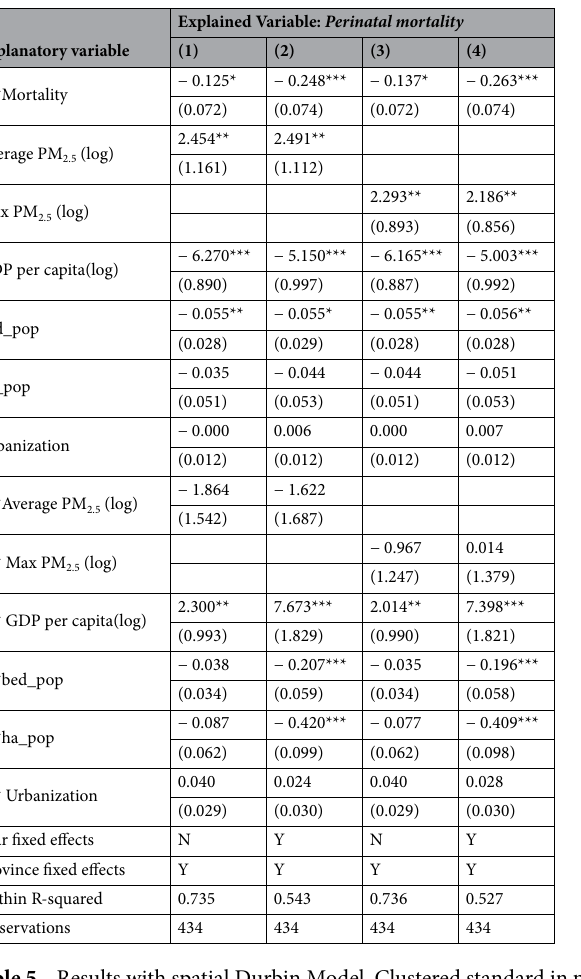
Table 5. Results with spatial Durbin Model. Clustered standard in parentheses, * p < 0.1, ** p < 0.05, *** p <